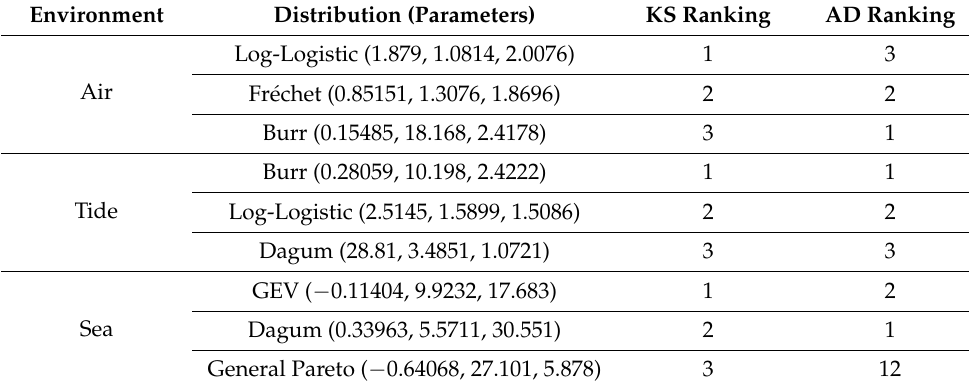
Table 7. The three best-fitted three-parameter distributions for the NiTi-1 alloy in air, tide and sea